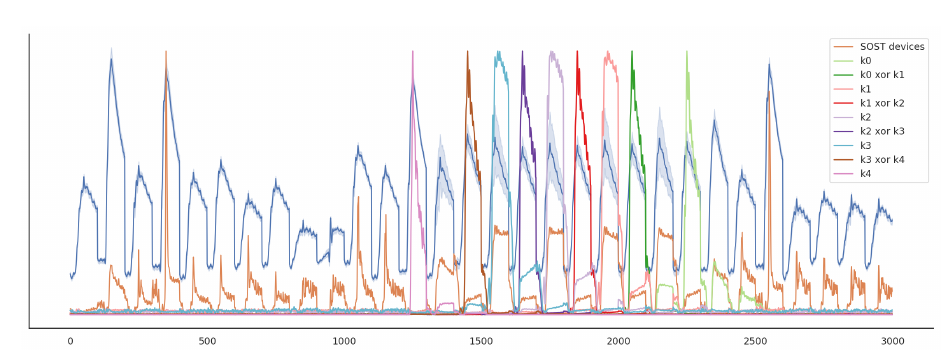
Figure 6: The average preprocessed trace with error bars indicating the spread over the different devices (in blue). Additionally, for each of the nine labels, this plot shows the regions of leakage identified by the SOST. The SOST result shown in orange indicates the locations in the trace containing information on the inter-device difference. All of the SOST results are scaled to fit the plot. Best viewed on